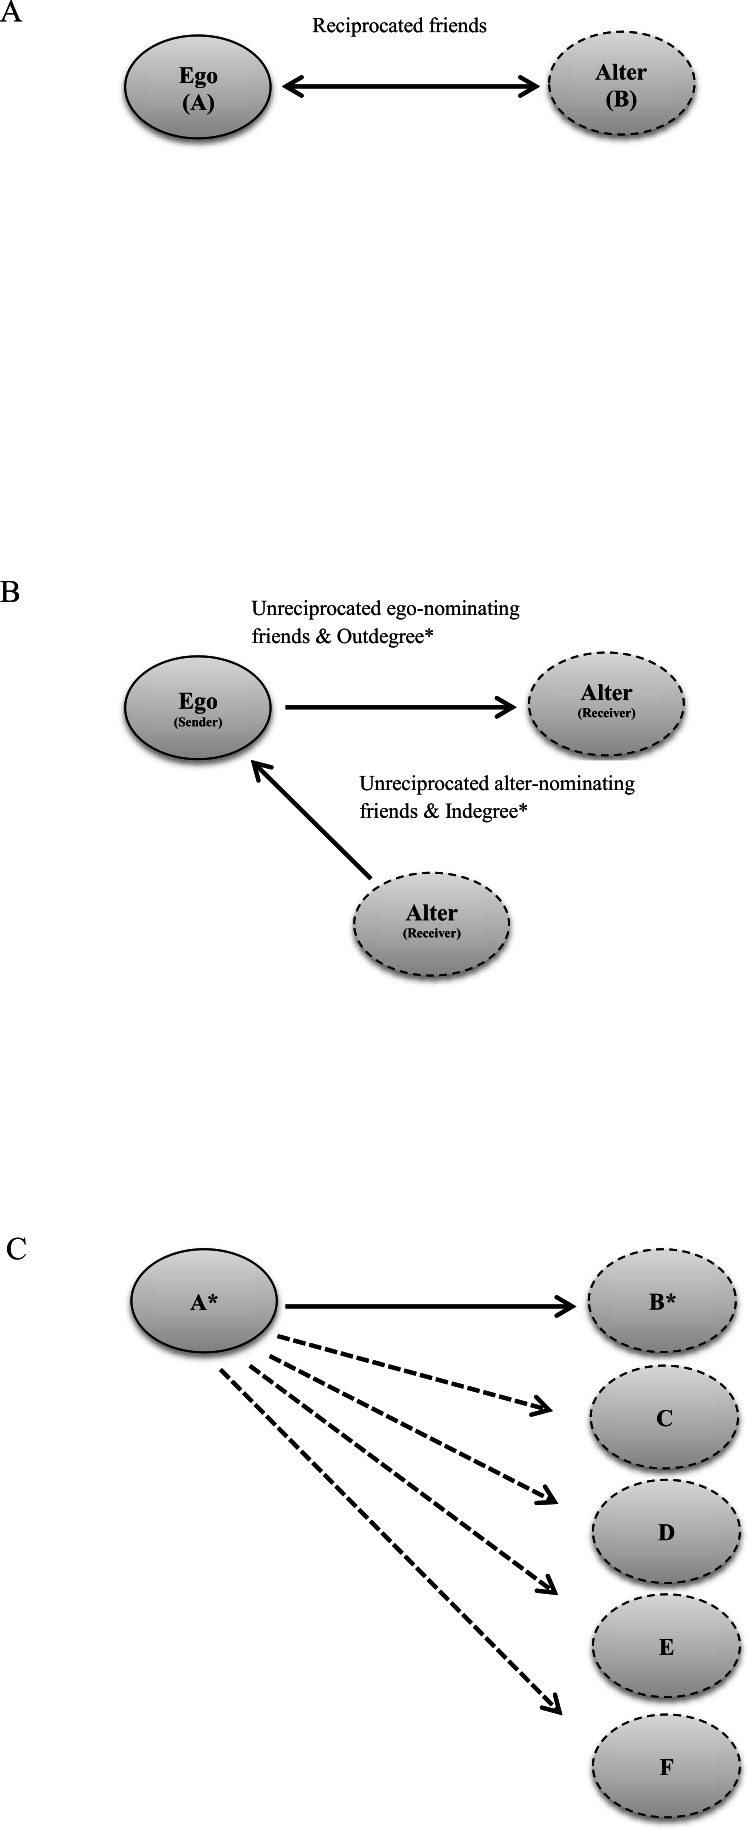
Diagrams of the three types of friendships examined by Fujimoto & Valente (2012a).(A) Mutual/Reciprocated friendships. (B) Directional friendships: ∗Outdegree is the number of friendship ties that the ego who is a focal point within a network “sends” & ∗Indegree is the number of friendship ties that the ego “receives” (Hall & Valente, 2007). (C) Intimate friendships: ∗B was nominated as best or close friends by A; C–F were nominated as friends, but not best or close friends.